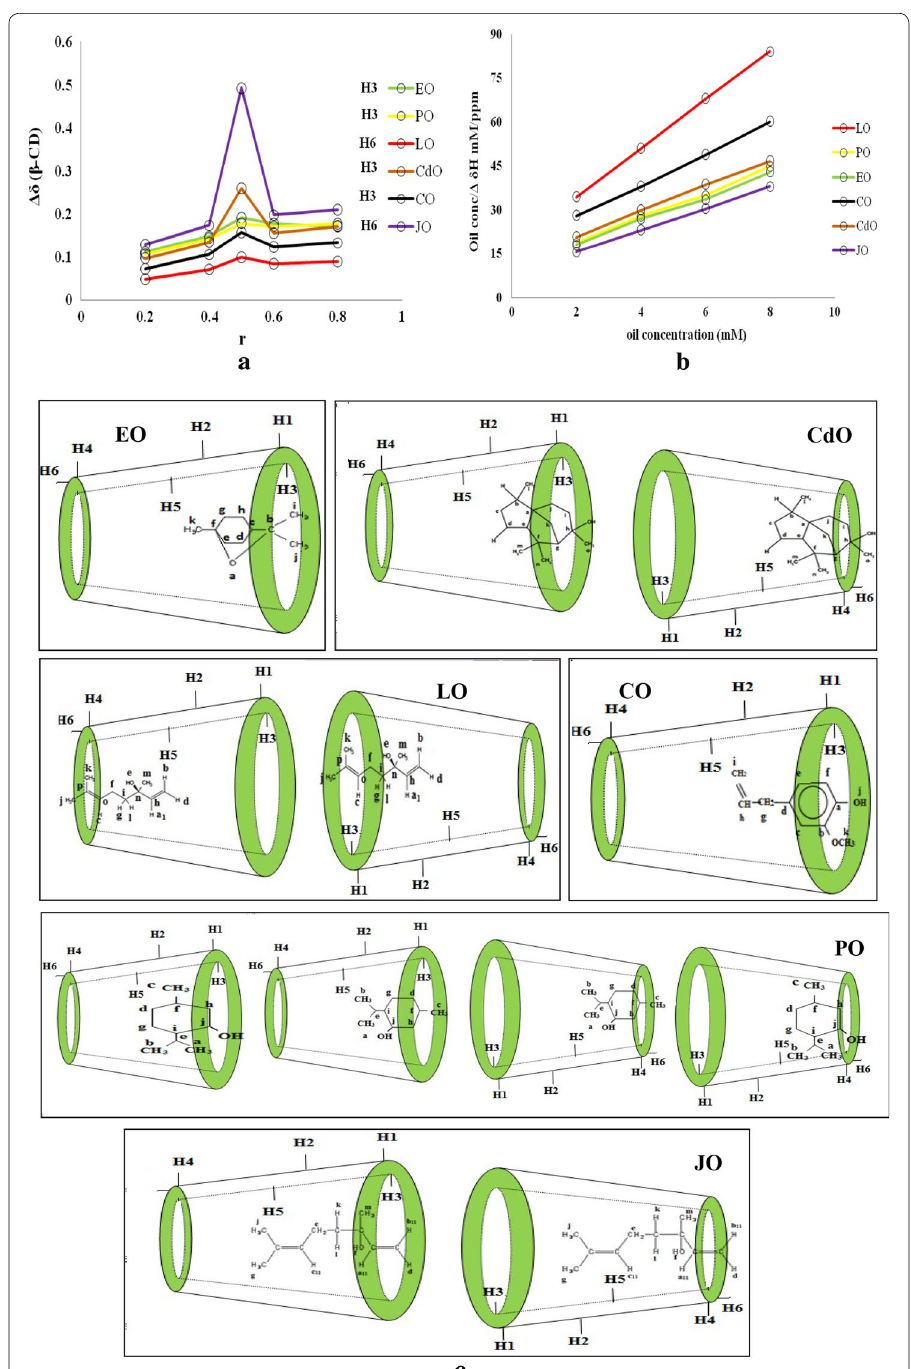
Fig. 8 a Job’s plot of host–guest complexes at varying ‘r’. b Scott’s Plot for Eos: β-CD CA ICs with r c Behavior of Eos within the β-CD CA